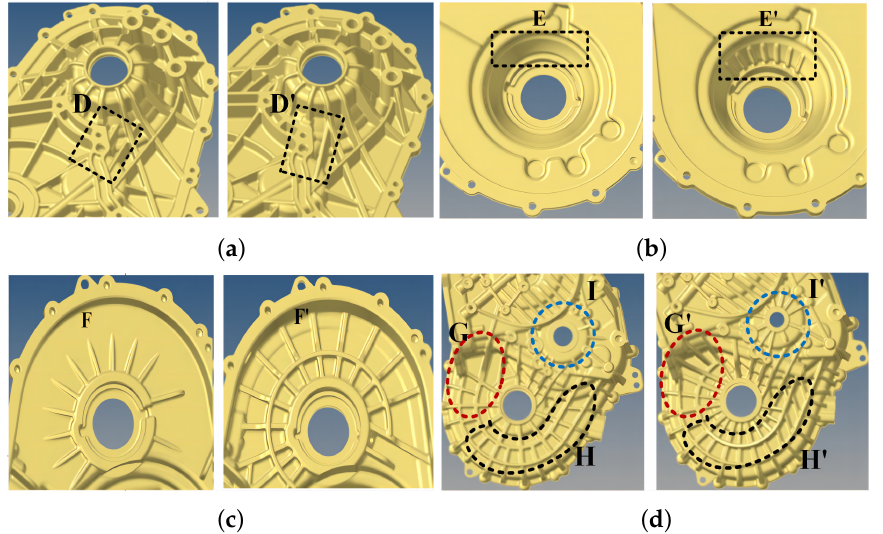
Figure 14. ( a ) Exterior of the output end of the front gearbox housing. ( b ) Interior of the output end of the front gearbox housing. ( c ) Interior of the output end of the rear gearbox housing. ( d ) Exterior of the output end of the rear gearbox